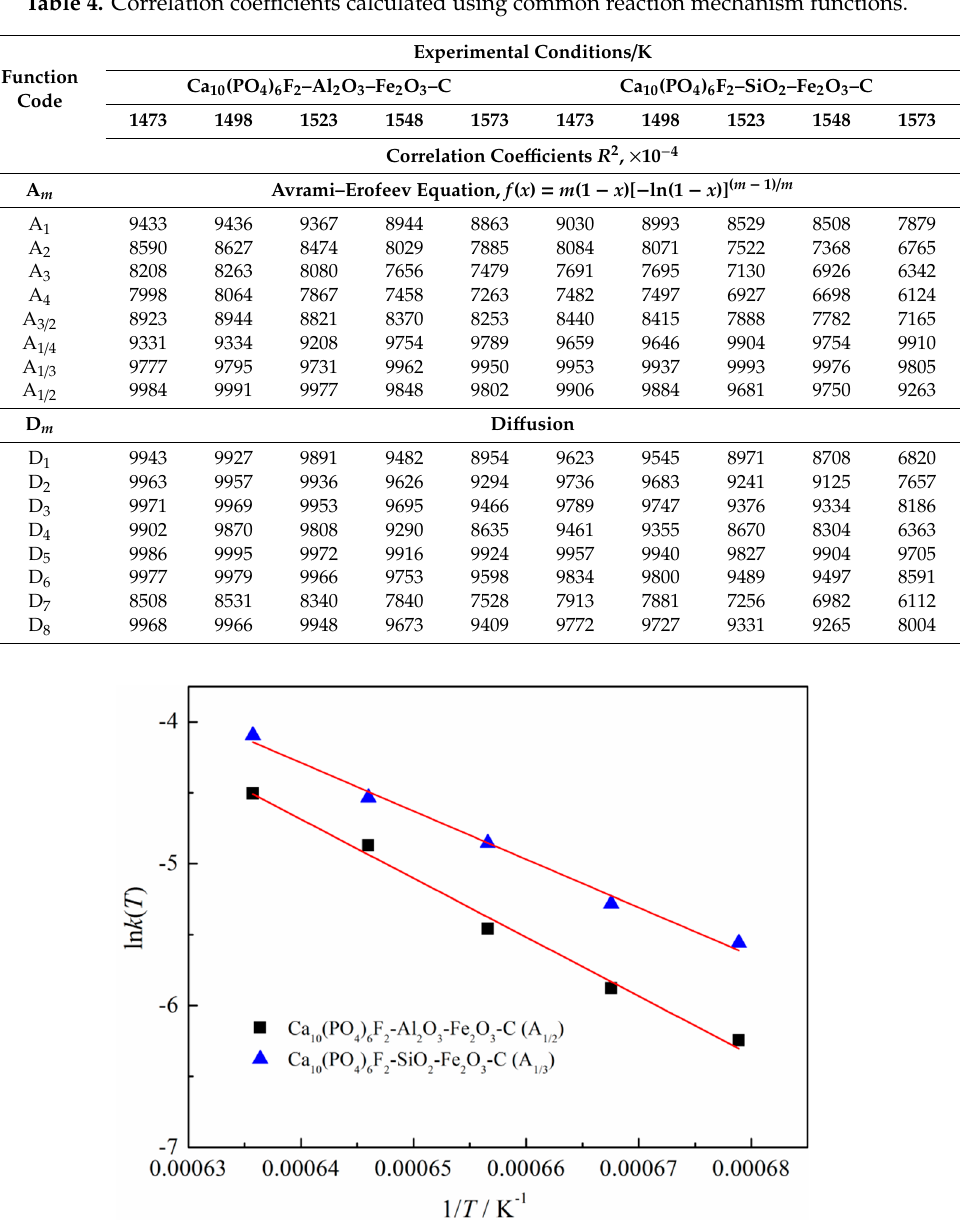
Table 4. Correlation coe ffi cients calculated using common reaction mechanism functions.